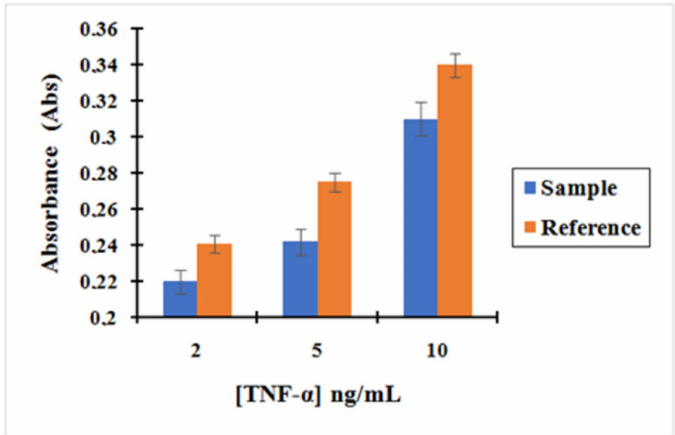
Figure 8. Bar graph showing (blue) the measurement of the absorbance after TNF- α incubation with the complex MNP@SiO 2 -NH 2 -CO-anti-TNF- α at three di ff erent concentrations of TNF- α : 2, 5, and 10 ng / L; (Orange) the measurement of the absorbance of TNF- α after incubation with no activated MNPs. Background fixed in artificial saliva at 1 / 500. Error bars correspond to three replicates per